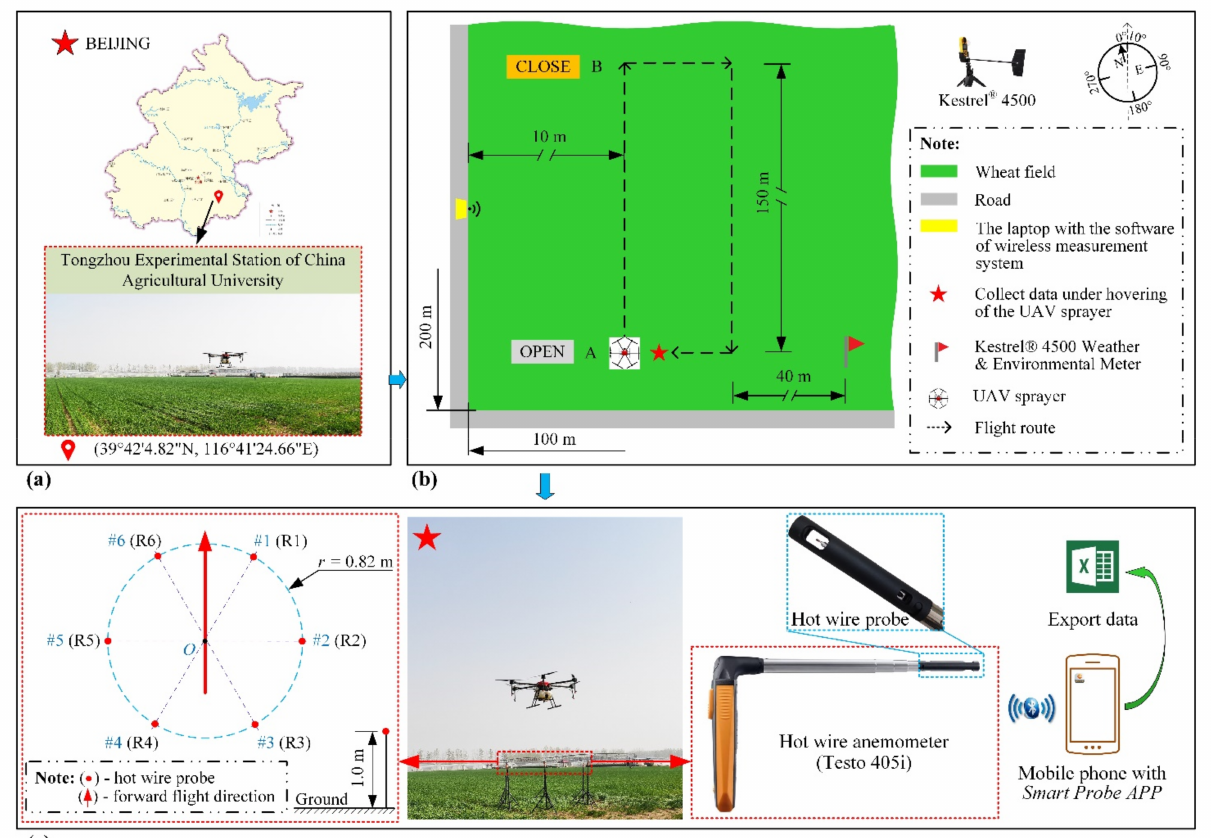
Figure 6. The simulation parameters measurement experiments. ( a ) Experimental location; ( b ) schematic diagram of the experimental area; ( c ) layout of Testo 405i when collecting data under hovering of the UAV